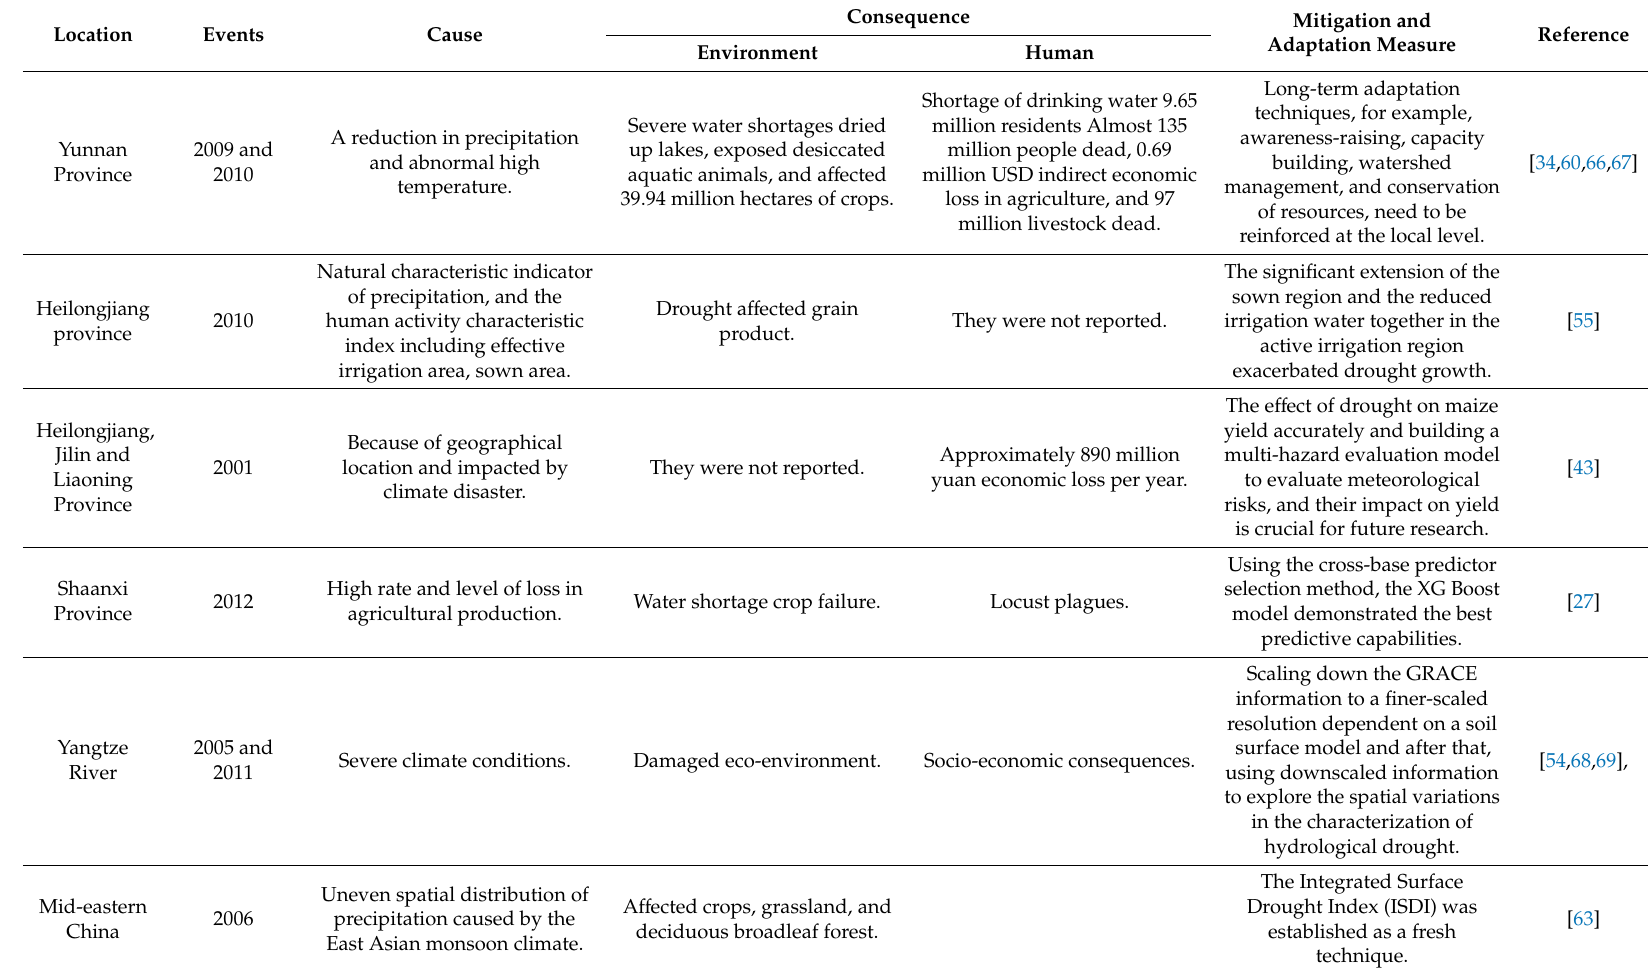
Table 2. Characteristics of key studies for drought